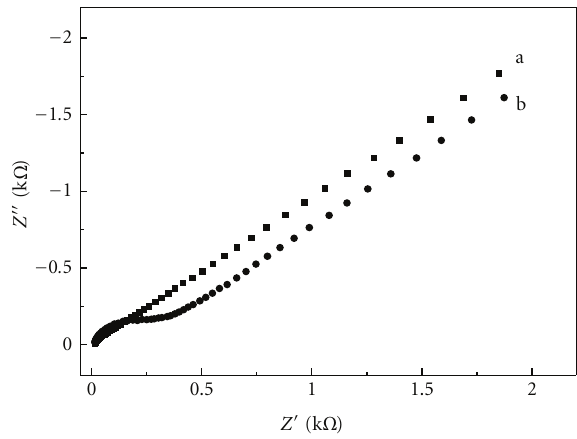
Figure 3: Cyclic voltammograms of bare GCE (a) and nano- CuO/GCE (b) in 0.01 M NaOH + 0.09M KCl solution containing 0.1mM H 2 O 2 . Scan rate: 0.10Vs − 1 .